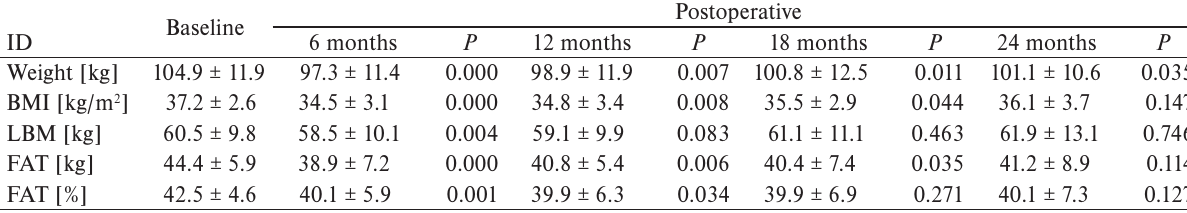
Table 2. Anthropometric parameters before and 6, 12, 18, and 24 months after ESG (n=20). Baseline